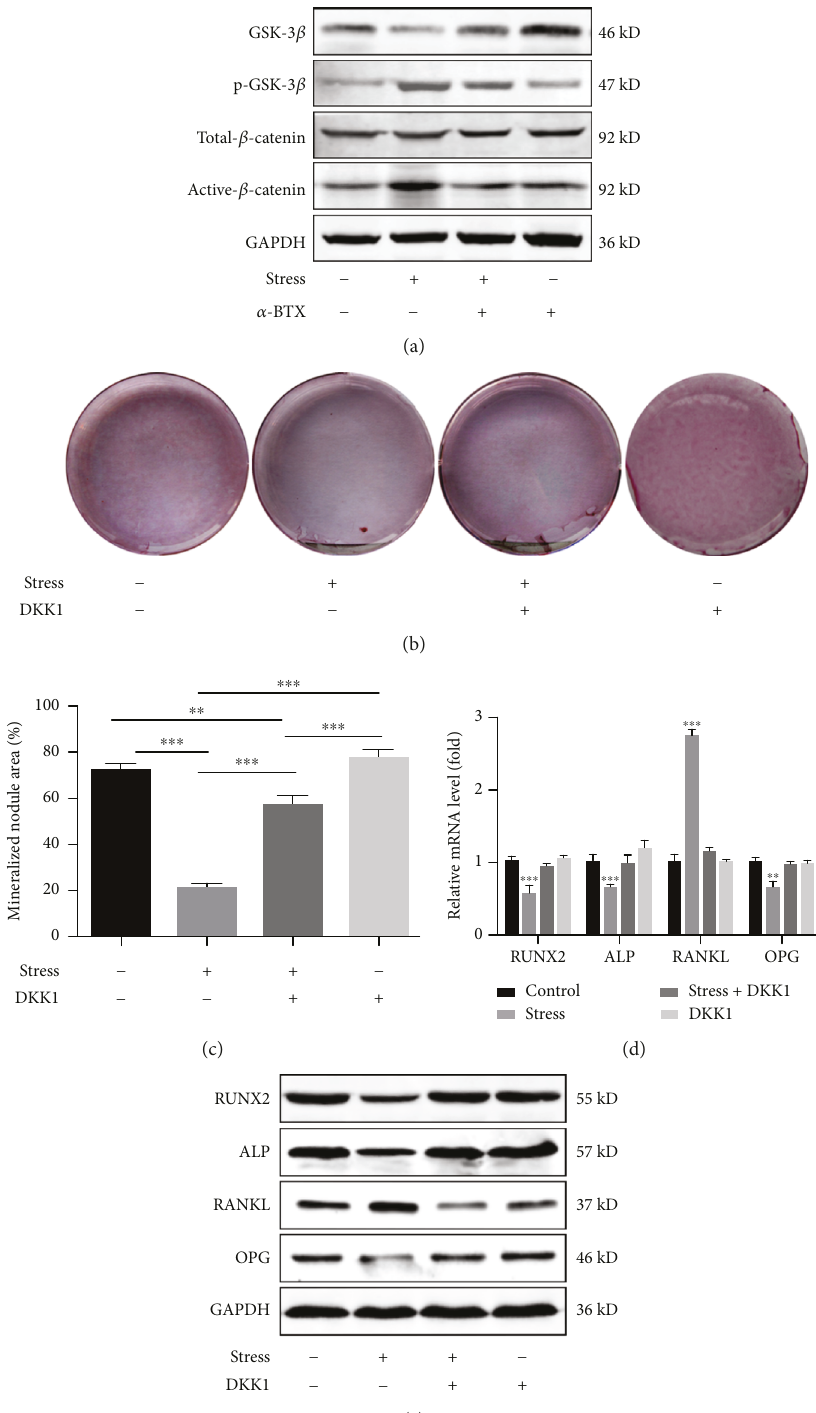
Figure 4: The Wnt/ β -catenin signaling pathway analysis of genes in response to mechanical stress. (a) Western blot assays showing the expression levels of GSK-3 β , p-GSK-3 β , total- β -catenin, and active- β -catenin in the UN group PDLSCs. (b) Alizarin red staining of PDLSCs from all groups after culturing in the osteogenic medium for 21 days and the entire plate views of each group. (c) Quantitative analysis for mineralized nodule formation via alizarin red staining of PDLSCs from all groups. (d) Relative mRNA expressions of RUNX2, ALP, RANKL, and OPG from UN group PDLSCs. (e) The Western blot assay results show the expression levels of RUNX2, ALP, RANKL, and OPG in PDLSCs from UN group PDLSCs. The cyclic hydraulic pressure was performed with a fi xed frequency of 0.1Hz at di ff erent ranges for 2 hours/day for three consecutive days (a, d, and e) and 21 consecutive days (b, c). Values have been expressed as mean ± SD . ( ∗ P ≤ 0 05 , ∗∗ P ≤ 0 01 , and ∗∗∗ P ≤ 0 001 ; one-way